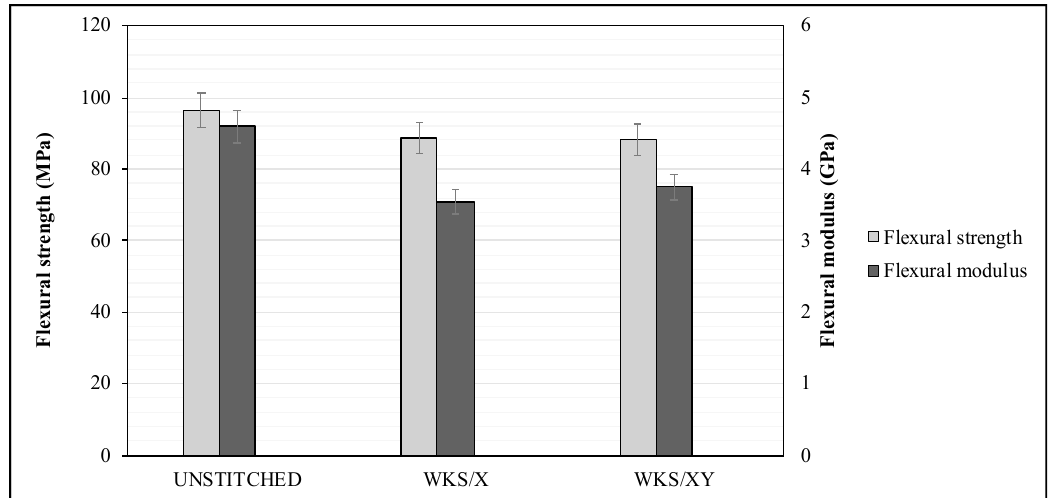
Figure 13. Effect of stitching density and pattern on the flexural properties of the unstitched and silk-fiber-stitched woven kenaf composites.